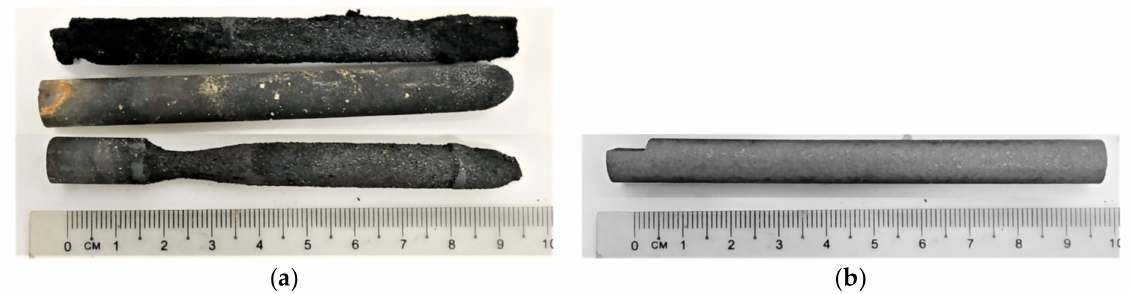
Figure 14. Erosion of the graphite bars ( a ) after treatment compared with ( b ) the initial condition.